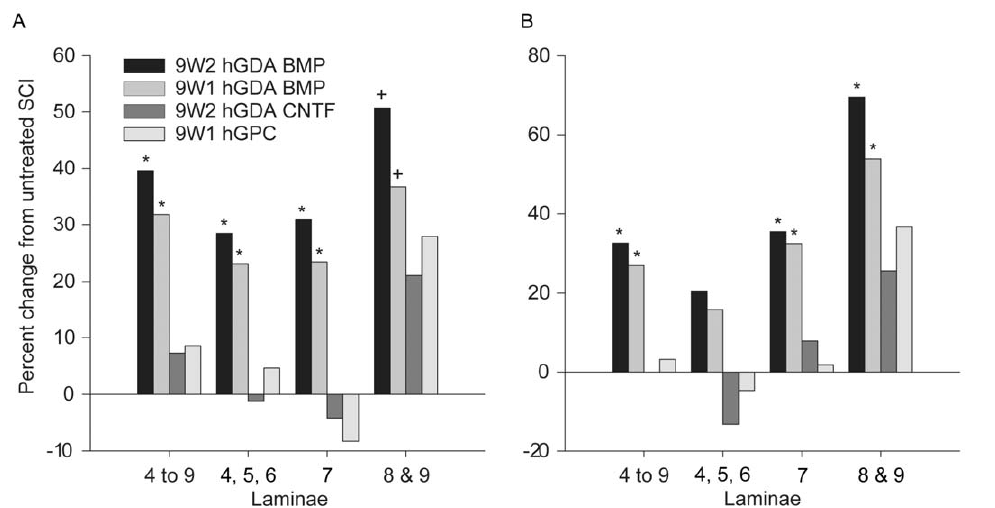
Figure 7. hGDAs BMP promote robust neuroprotection of spinal cord neurons but hGDAs CNTF and hGPCs do not. (A) hGDA BMP transplantation led to significant increases in numbers of NeuN + neurons counted in a 1.8mm length of spinal cord encompassing the injury site. Graphs show percentage changes in numbers of NeuN + neurons in laminae 4 to 9; laminae 4, 5, and 6; 7; and 8 and 9 in spinal cords from animals that received transplants of 9W2 or 9W1 hGDAs BMP , hGDAs CNTF or hGPCs and untreated control injuries. (B) Analysis of neuron survival within laminae immediately adjacent to the site of injury shows that hGDA BMP transplantation promoted significant protection of neurons when all laminae were considered (4 to 9), with the most robust increases in neuron numbers in intermediate (7) and ventral (8 and 9) gray matter laminae. Numbers of NeuN + neurons in spinal cords of rats transplanted with GDAs CNTF or hGPCs were not significantly different from each other or untreated spinal cord injuries. * ANOVA and Pairwise Multiple Comparison (Holm-Sidak), p , 0.05. + t-test comparison with untreated spinal cord injuries, p , 0.05.